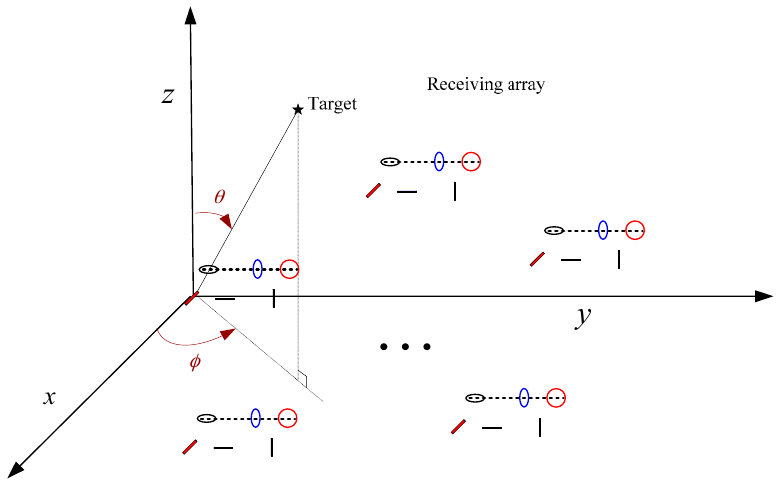
Figure 3. Monostatic MIMO radar with arbitrarily spaced separated EMVSs. Table 1. Spatial phase shift factor of separated electromagnetic vector sensor with arbitrary